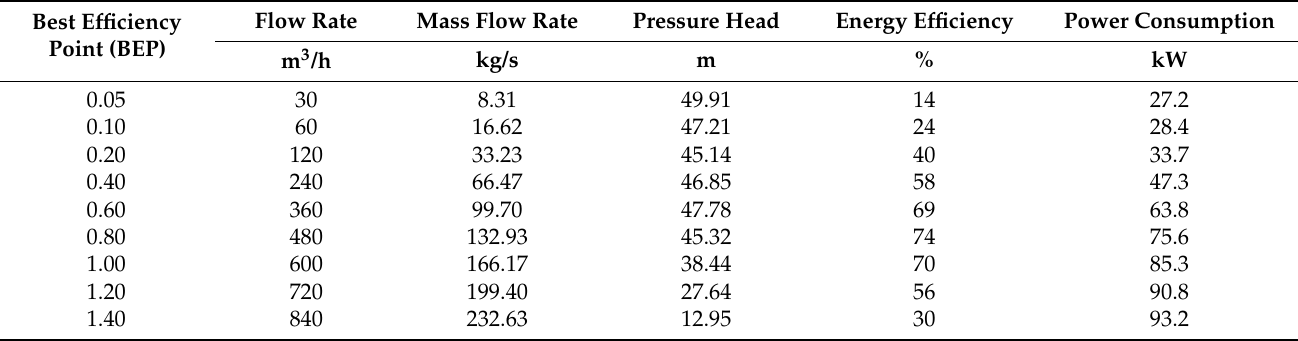
Table 2. Results of parametric tests for the developed pump ACNA 600-35 (fluid density ρ = 997 kg/m 3 ; rotation speed n = 1500 rpm).